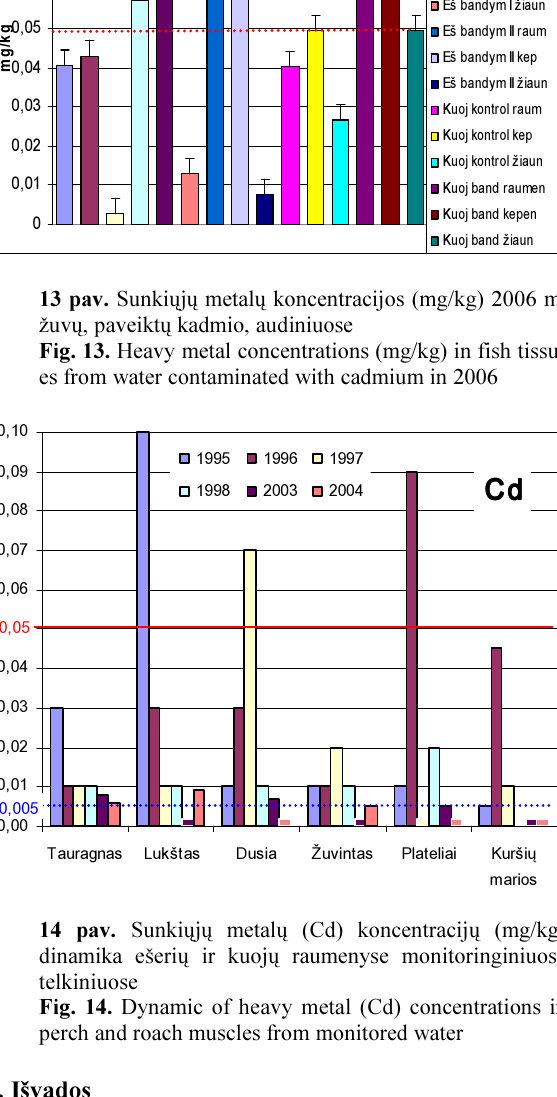
Fig. 14. Dynamic of heavy metal (Cd) concentrations in perch and roach muscles from monitored